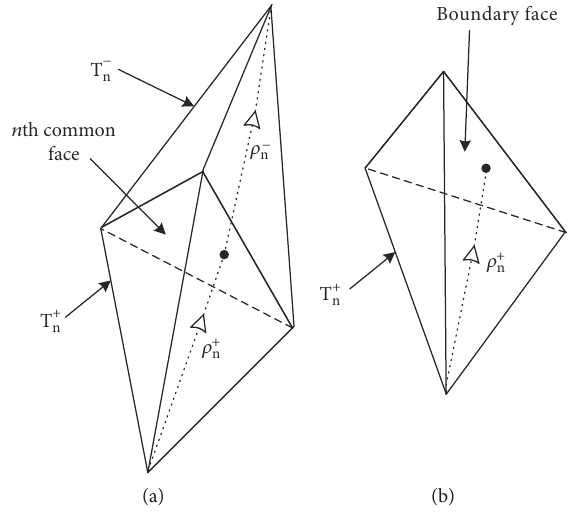
Figure 1: (a) SWG pair and (b) half-SWG associated with the n th element. T + n and T − n are the tetrahedron pairs and ρ + n and ρ − n are the position vectors, respectively. For the boundary element, the basis functions are all de fi ned with half-SWG in T + n in this